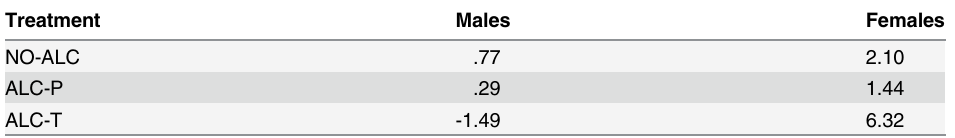
Table 5. Risk aversion by Treatment and